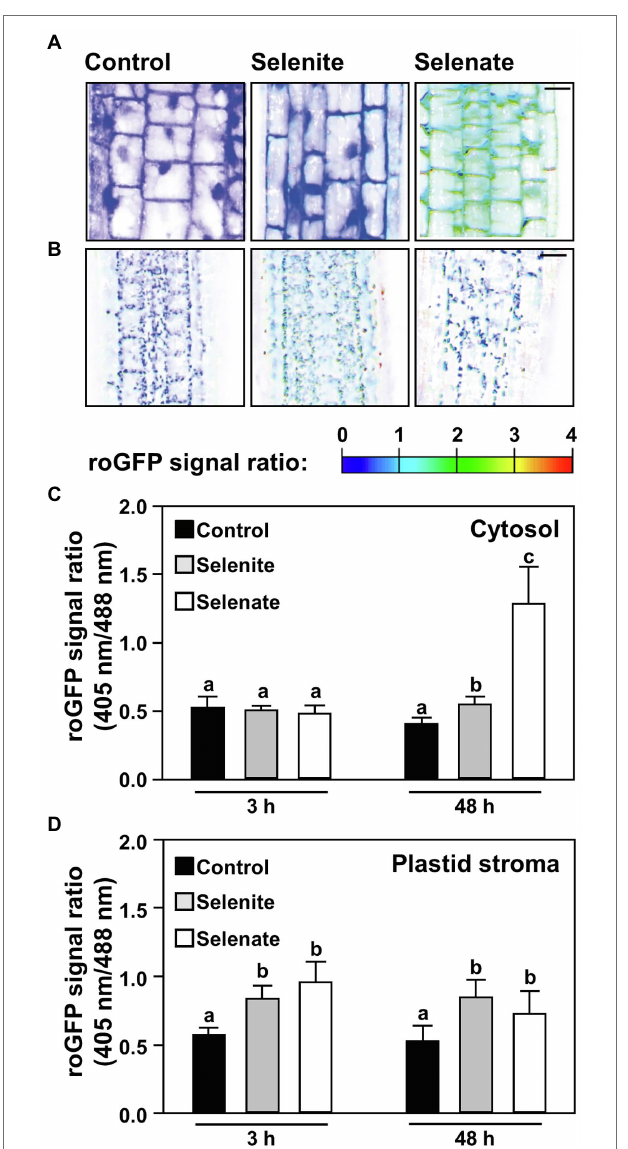
FIGURE 6 | Time-resolved impact of selenium species on the cytosolic and the plastid glutathione redox state in leaves of Arabidopsis . (A,B) Representative false-color images of the Grx1-roGFP2 signal ratio in the cytosol (A) or plastids (B) of leaves from hydroponically grown plants treated with selenite, selenate or without additional selenium supply for indicated time points via the root system. Arabidopsis plants expressing the Grx1-roGFP2 sensor in the cytosol or plastids were treated for up to 2 days in ½ Hoagland medium (control), supplemented with either 50 μ M Na 2 SeO 3 (selenite) or 50 μ M Na 2 SeO 4 (selenate). roGFP2 was excited at 405 nm and 488 nm, respectively, and fluorescence was collected at 505–530 nm. The 405/488- nm fluorescence ratio is shown on a false-color scale spanning full reduction of roGFP2 (blue) to full oxidation (red). Images were digitally extracted for comparison. Scale bar = 20 μ m. (C,D) The roGFP2 ratio signal is indicating relative changes of the glutathione redox potential in the cytosol (C) or the plastid stroma (D) of leaves treated for the indicated times with ½ Hoagland medium (control, black), supplemented with selenite (gray) or selenate (white). Data are shown as mean values ± SD. Different lowercase letters indicate individual groups identified by pairwise multiple comparisons with a Holm- Sidak one-way ANOVA ( p = 0.05, n =